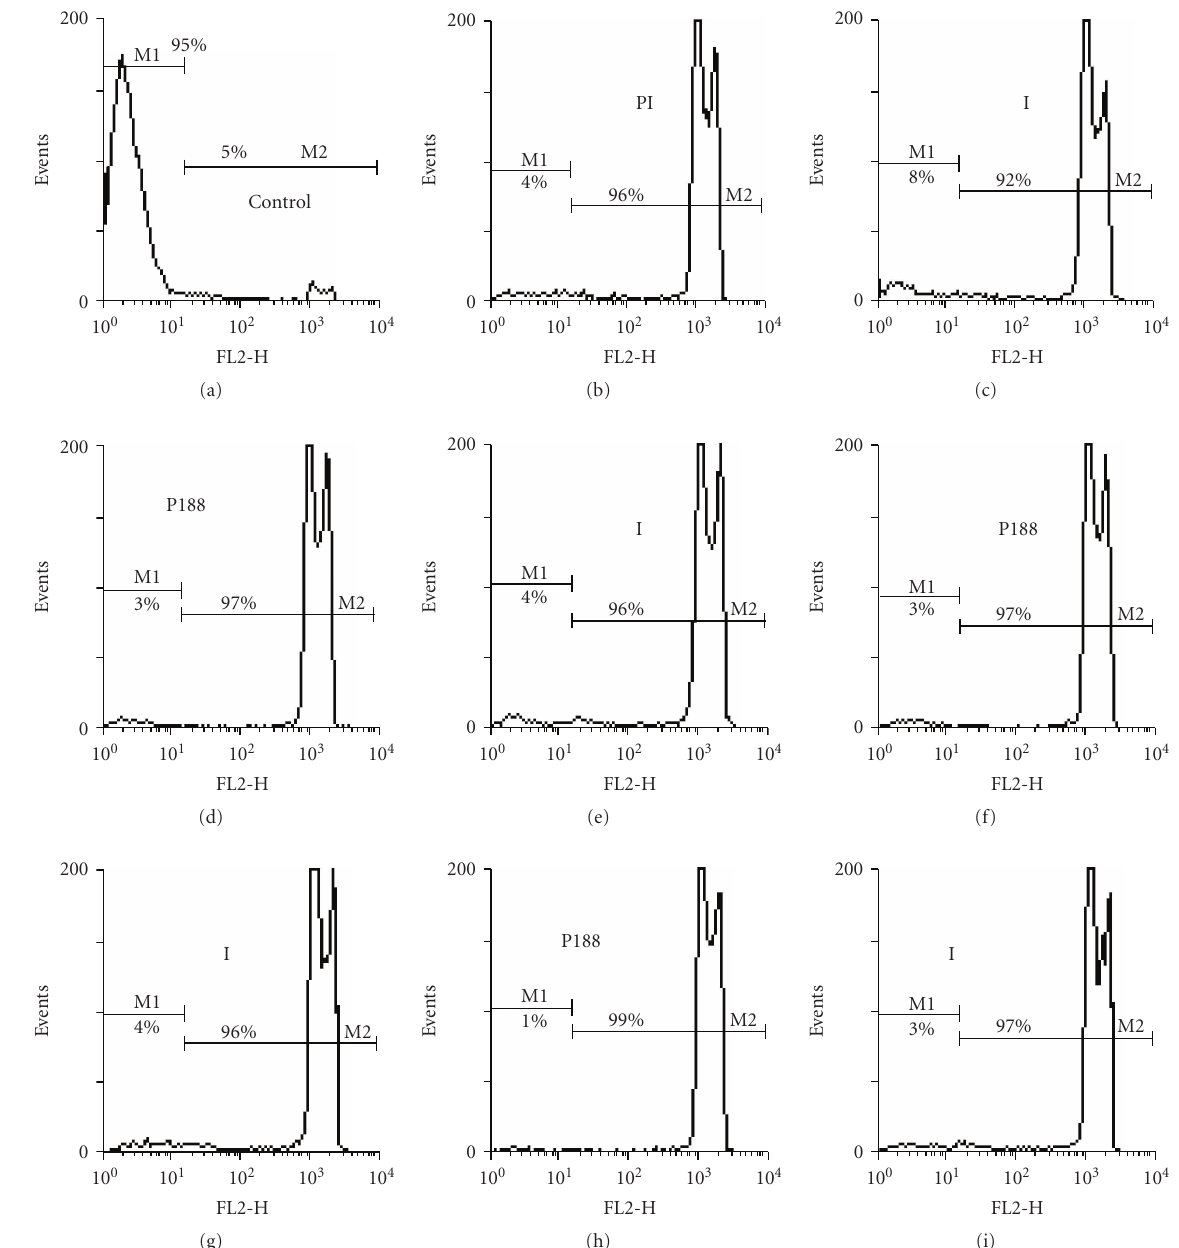
Figure 3: Flow cytometry of SKW-3 cells. Other conditions are the same as in Figure